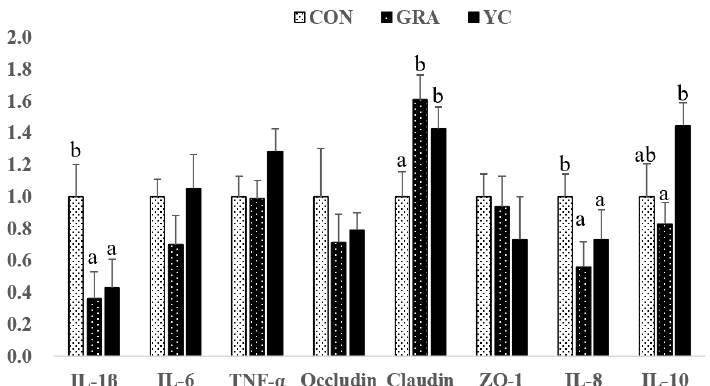
Figure 4. Effect of yeast culture supplementation on the mRNA levels of immunity-related genes in ilea of finishing pigs. IL-10, interleukin 10; TNF- α , tumor necrosis factor- α ; IL-1 β , interleukin-1 β ; IL- 6, interleukin-6; IL-8, interleukin-8; ZO-1, zonula occludens-1. Values are means and SEMs, n = 6 per group. a,b p < 0.05 between different superscripts within the same